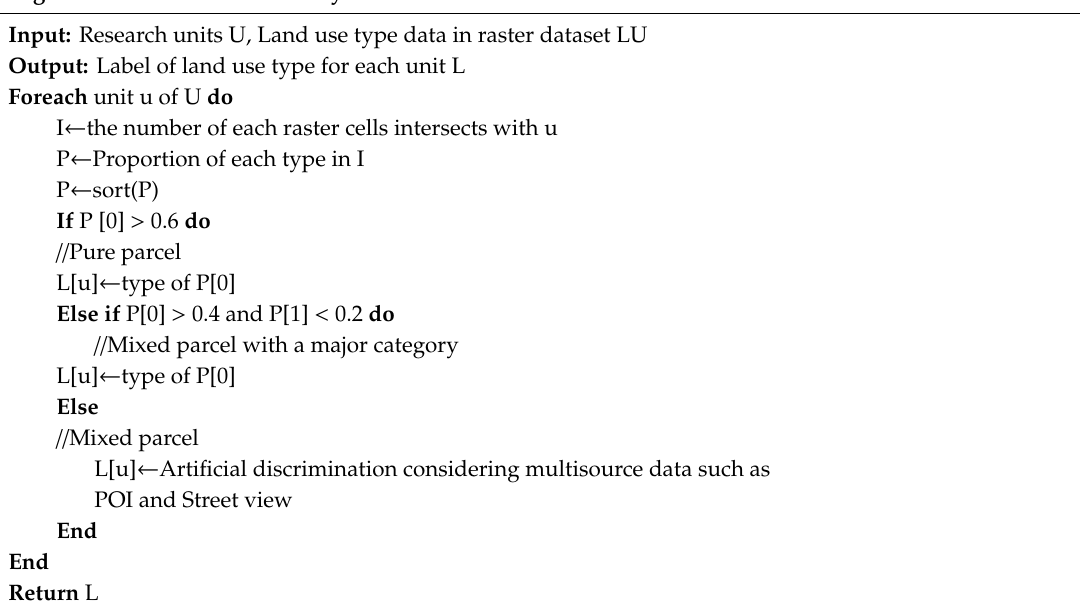
Algorithm 1 Semi-Automatically Label